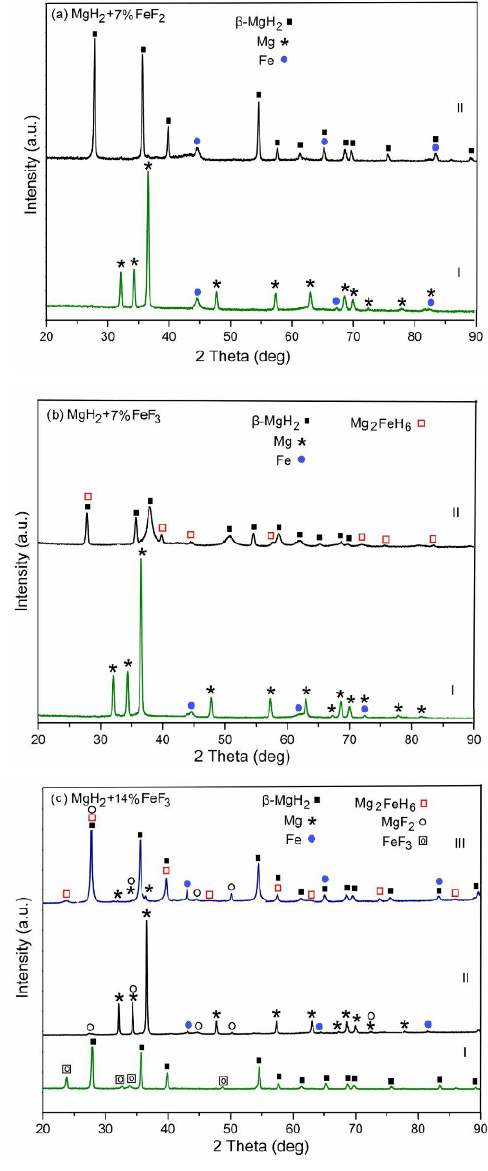
Figure 1. XRD diffraction patterns of MgH